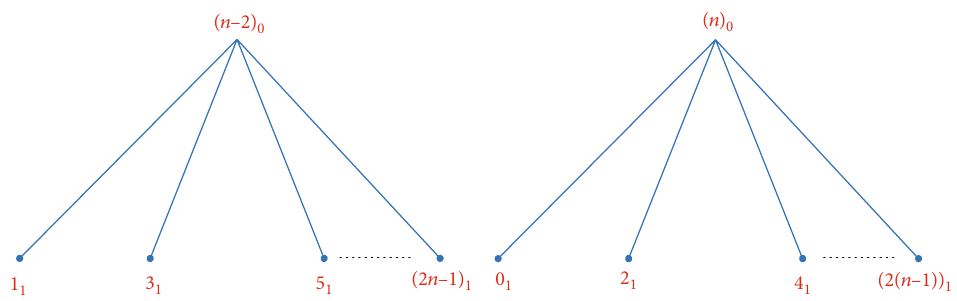
Figure 14: An orthogonal labeling for 2 K